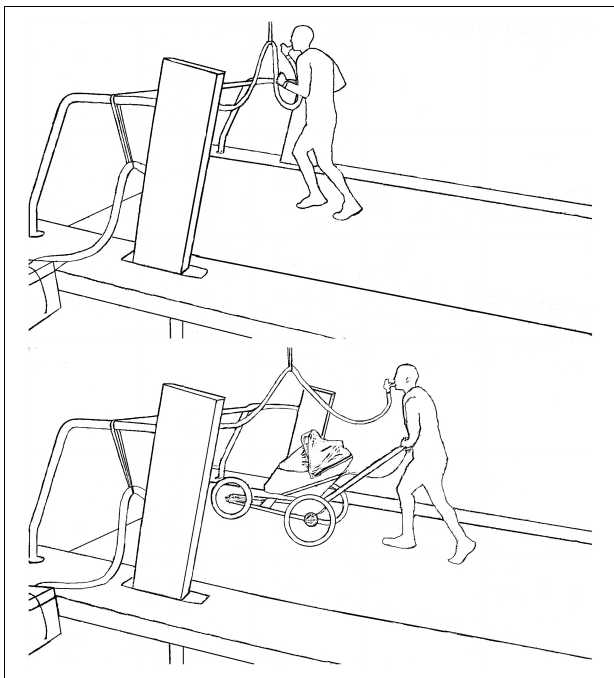
FIGURE 1 | Comparison of stroller running and unloaded running while testing on the